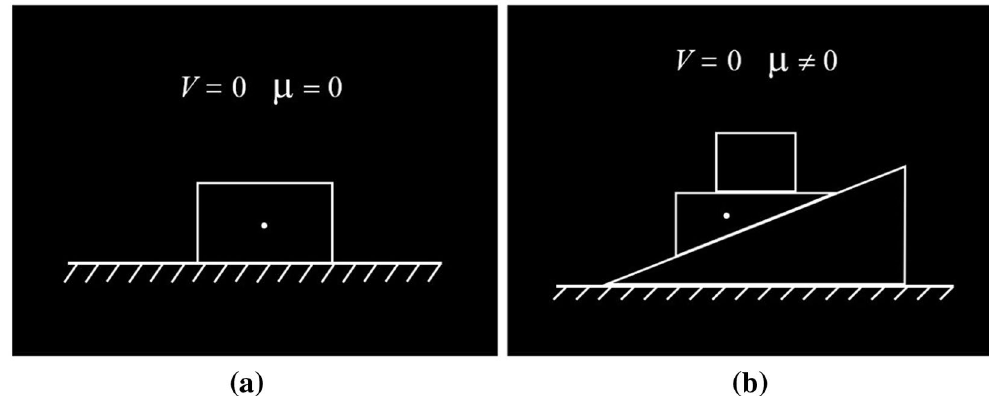
Figure 3. Examples of scientific problems presented in the task. Problems are illustrated as the symbolic diagrams commonly used in science education practice. Students are asked to determine the number of forces acting on the object marked by the small white dot. The velocity of the object ( V ) and the friction of contacting surfaces ( μ ) are shown in the diagram. ( a ) Low complexity scientific problem. ( b ) High complexity scientific